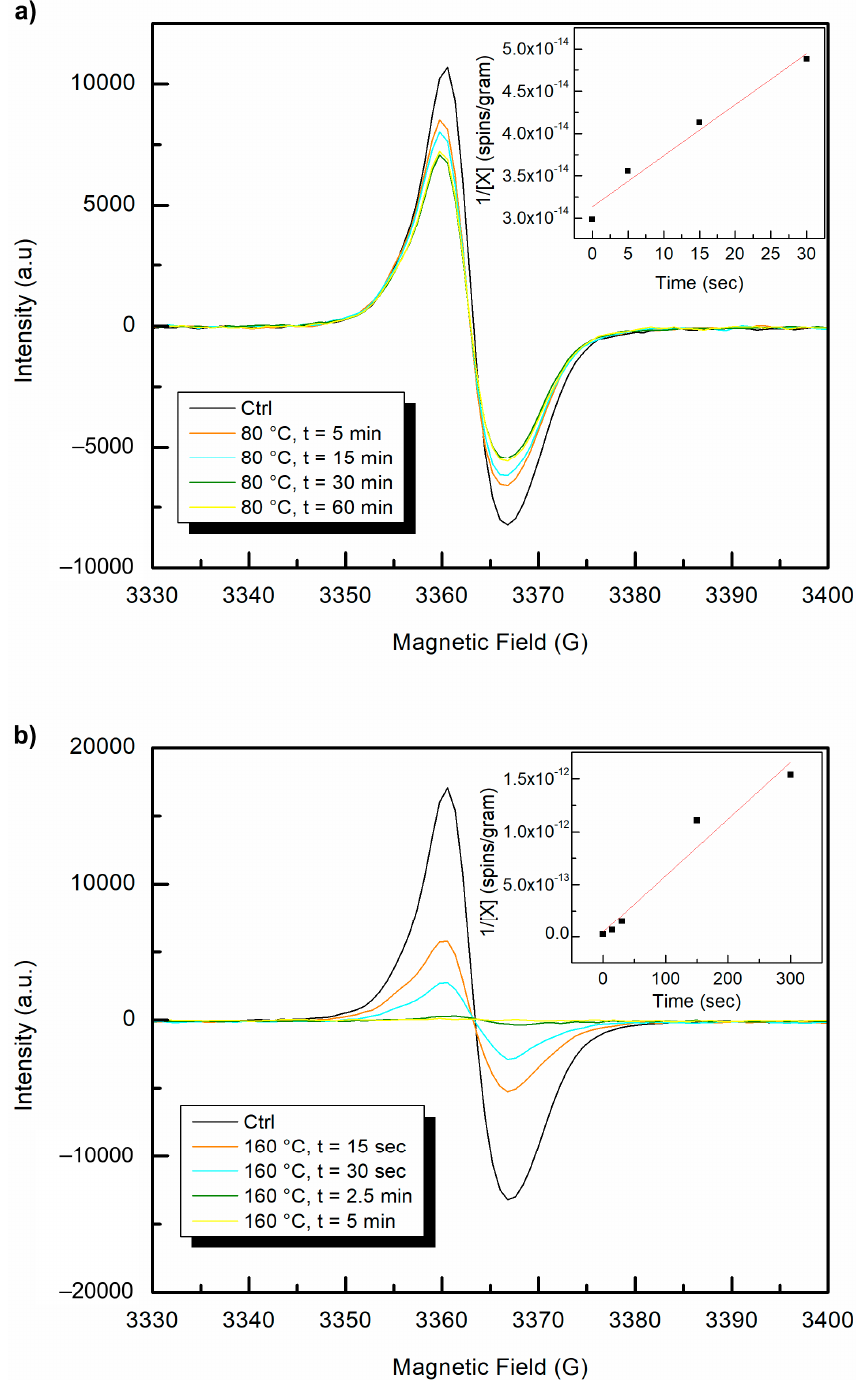
Figure 11. EPR polyenyl free radical spectra of UHMMPE fibers six years after gamma irradiation at 50 kGy. Post irradiation heat treatment at ( a ) 80 °C and ( b ) 160 °C and the kinetics of free radical decay. Inset plots show the change in spins per gram as a function of heating time.